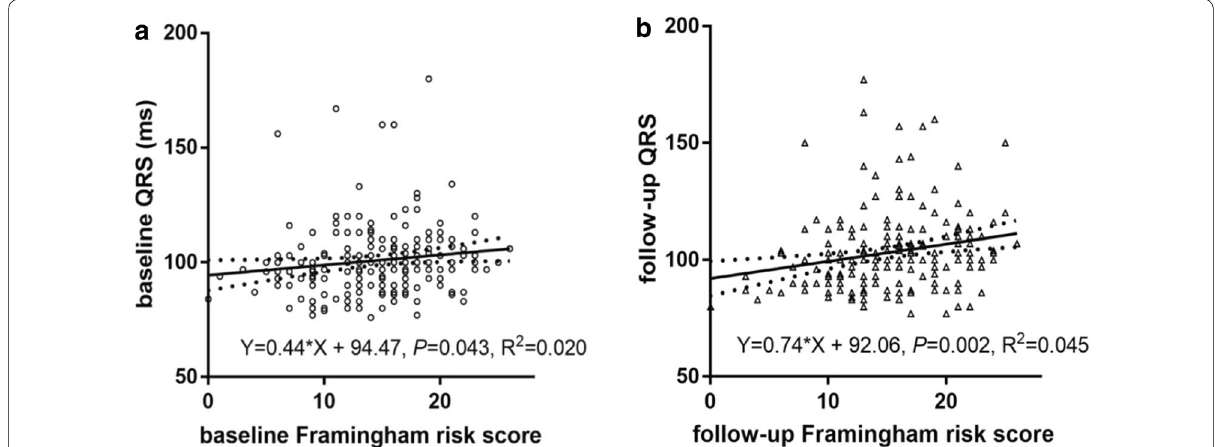
Fig. 1 Cross-sectional association between QRS duration and Framingham risk score at baseline and follow-up clinic